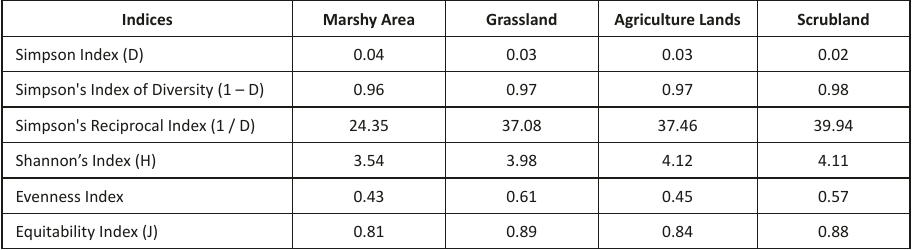
Table 3. Diversity indices values of birds in different habitats of Manjeera Wildlife Sanctuary, Andhra Pradesh, India